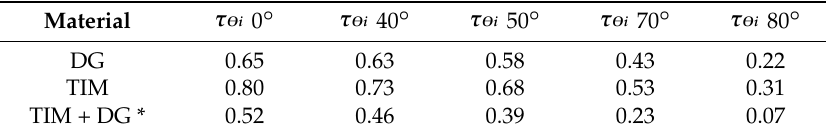
Table 8. This dependence is obtained by Matuška [56], assuming zero transmittance for the incidence angle 90°. Theoretically, for system that combines double low-e glazing and honeycomb transparent insulation, the calculated value can be derived by their multiplying to correspond its approximate value. For outdoor tests, a specific approach of monitoring the total solar transmittance responding to the outdoor conditions can be applied. Angular solar transmittance values τ Ө i [56].